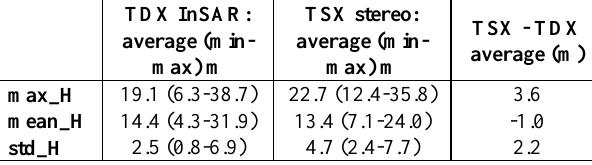
Table 4. A comparison of plot tree height statistics from TDX and TSX data.